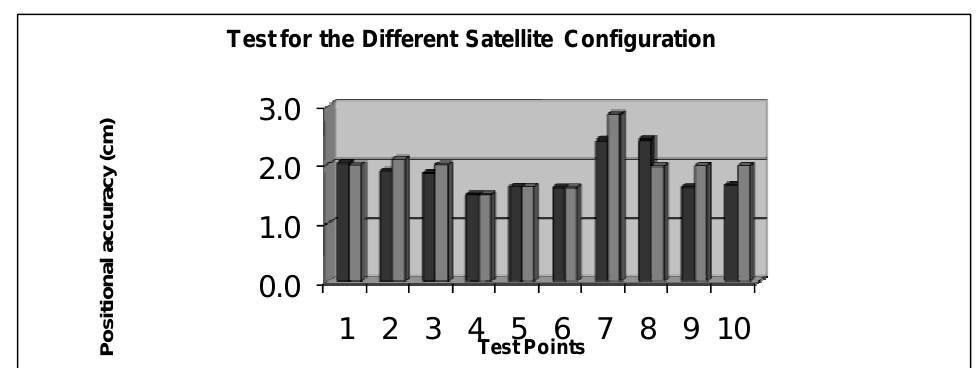
Figure 4 . Positional accuracies for Case